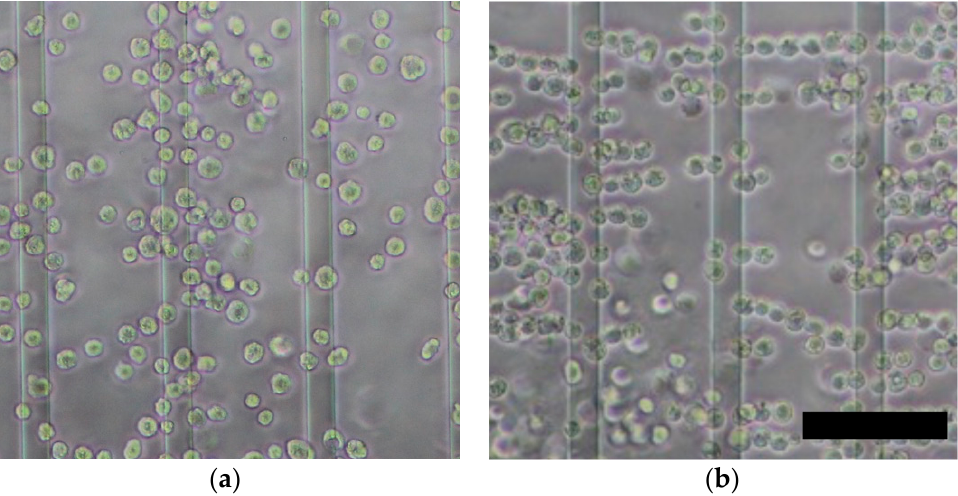
Figure 5. Formation of pearl-chain-like cell aggregates by positive DEP. Phase-contrast images of chondrocytes ( a ) before and ( b ) after positive DEP for 180 s. Scale bar = 100 μ m.